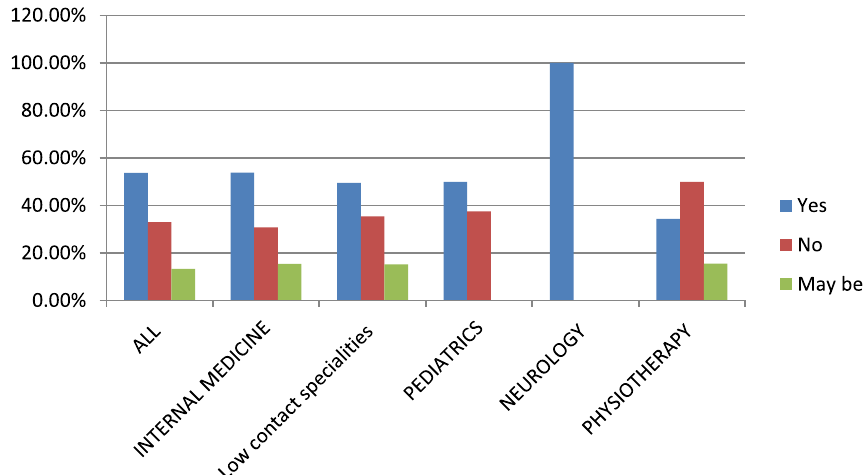
Fig. 4 The percentages and comparison among the participants in different specialties regarding their responses about the presence of phoniatrics specialty in their